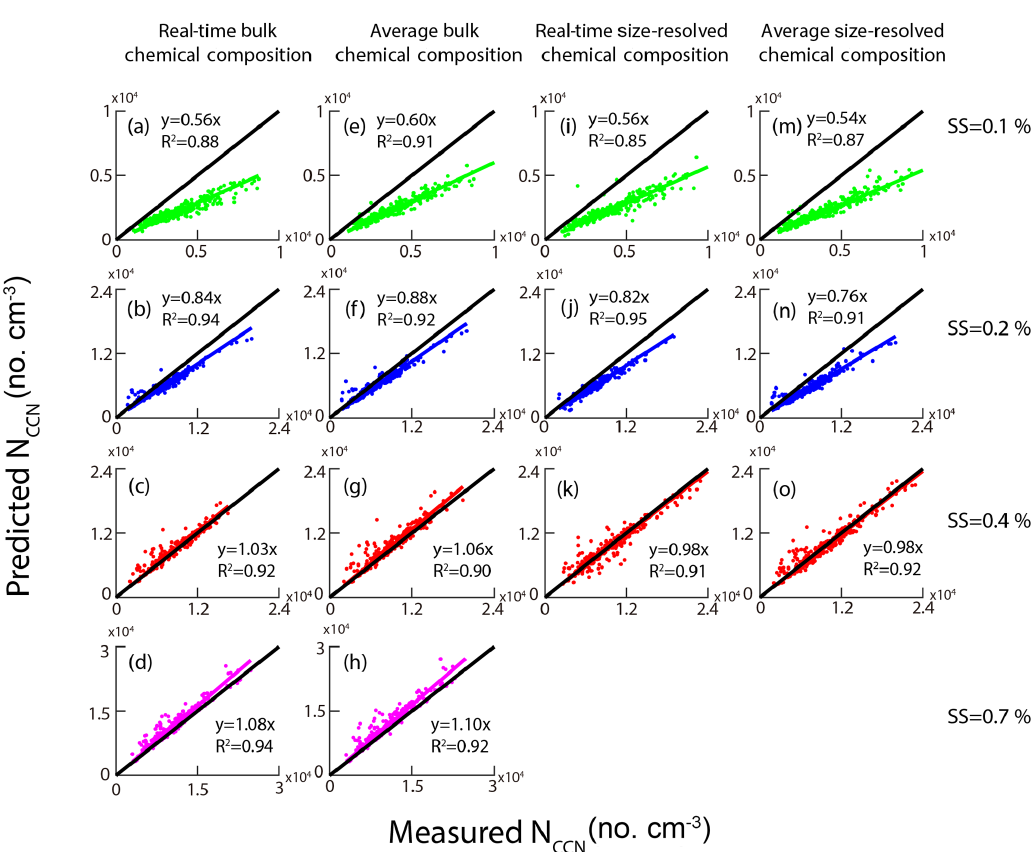
Figure 11. The relationship between measured N CCN and predicted N CCN based on schemes 6, 7, 8, and 9. The black lines represent 1 : 1 lines.